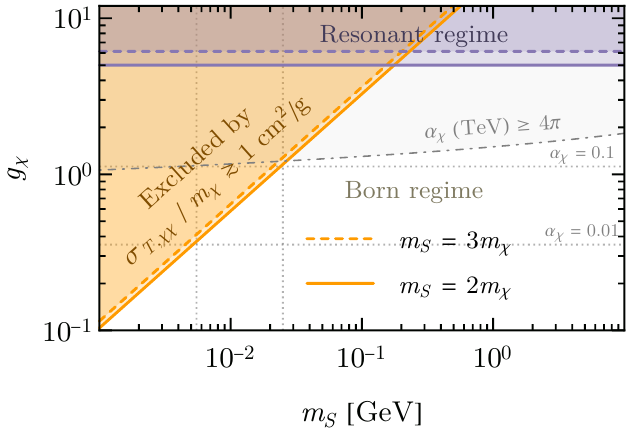
p Figure 1. Constraints on g 1 + (cid:15) R ) (cid:25) m S = 2 (solid) (cid:31) for m (cid:31) = m S = 3 (dashed) and m (cid:31) = m S = (2 from DM self-interactions and perturbativity requirements. The orange region is disfavored by astrophysical constraints such as halo morphism (see discussions in the text). The purple region indicates the resonant regime ( (cid:11) (cid:31) (cid:17) g 2 = 4 (cid:25) & m S =m (cid:31) and m (cid:31) v rel =m S . 1) where eq. (2.10) is not (cid:31) applicable. Above the gray dash-dotted line, (cid:11) (cid:31) runs to a value (cid:21) 4 (cid:25) at the TeV scale or